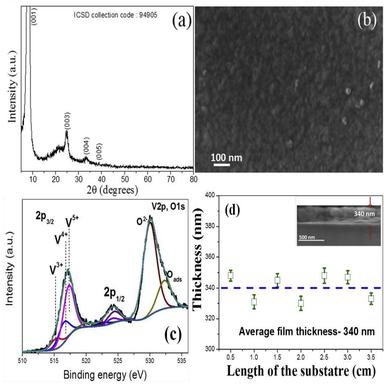
(a) XRD pattern, (b) FESEM image and (c) typical curve fitted V2p and O1s spectra and of as deposited FVO thin films on the quartz substrates and (d) thickness of as deposited thin film measured by cross-sectional FESEM of the as deposited FVO thin film as a function of length covered on the substrate.